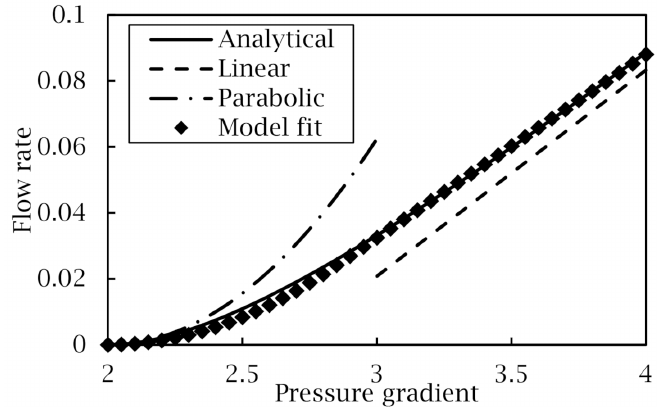
Figure A2. Results of non-dimensional flow rate changes with non-dimensional pressure gradient for Bingham flow through 3D cylinder. The flow rate changes parabolically when pressure gradient is small and linearly when pressure gradient is large. The model that links parabolic and linear form can well match the analytical solution